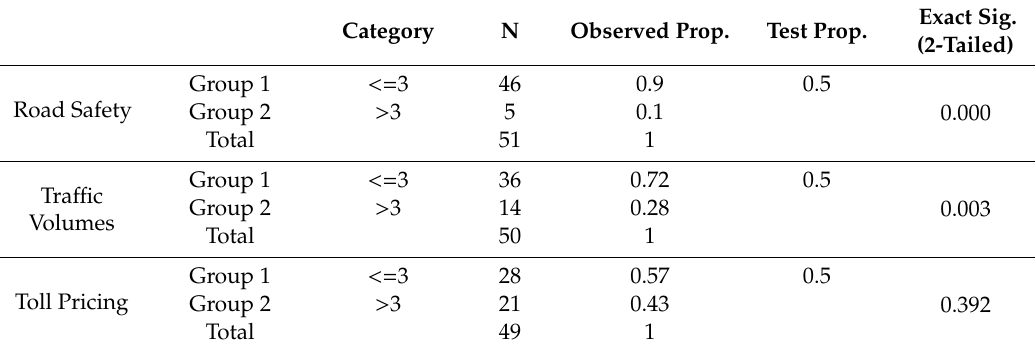
Table 10. Binomial test (Statistics) for autonomous vehicles on